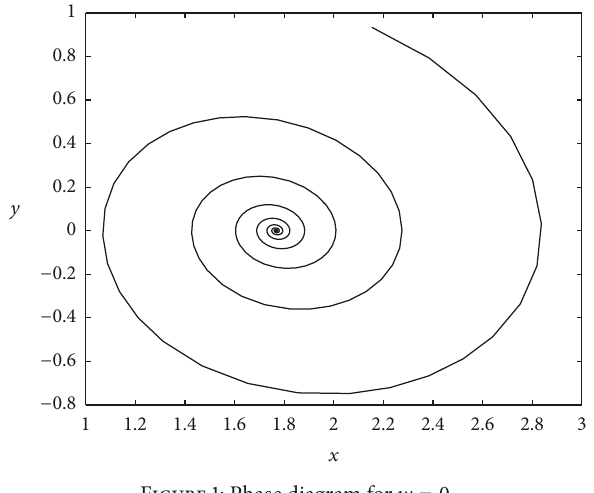
Figure 1: Phase diagram for 𝑤 = 0 .